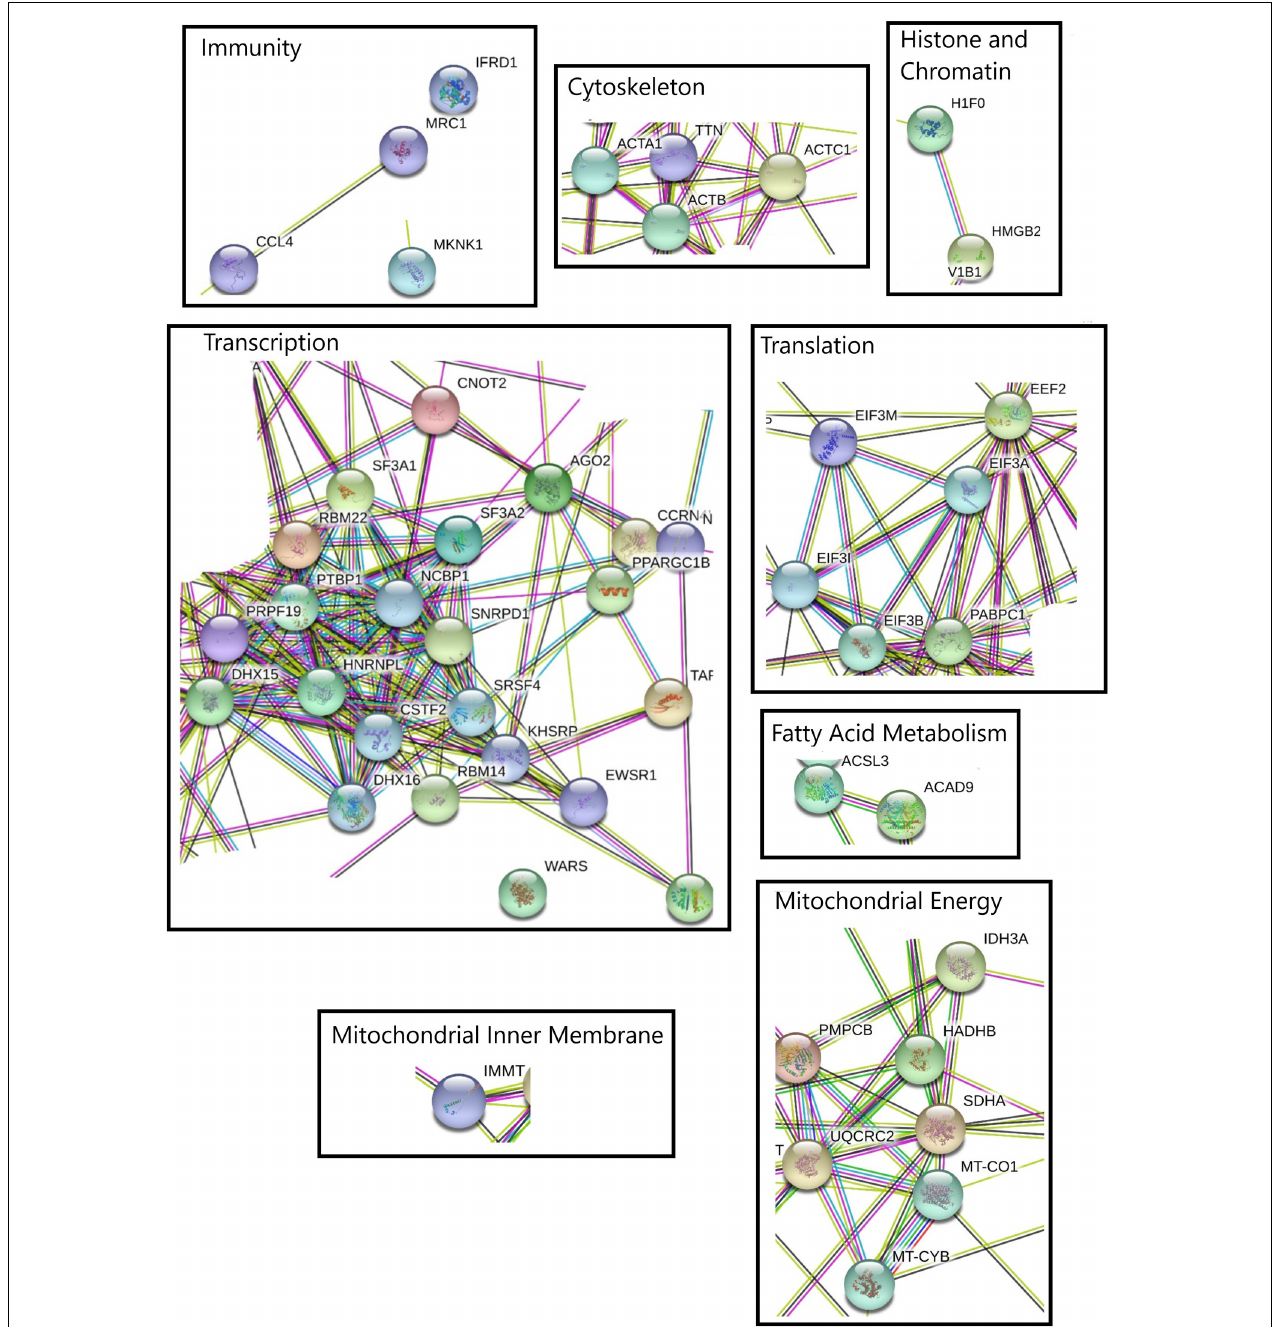
FIGURE 3 | Protein-protein interaction network performed with STRING online software using four kinetic points for down-regulated transcripts. The relevant molecular pathways were zoomed and placed in squares indicating cluster of transcript representations of each pathway. Please see Supplementary Material 3 and Supplementary Figure 5 for a complete view of protein-protein interaction